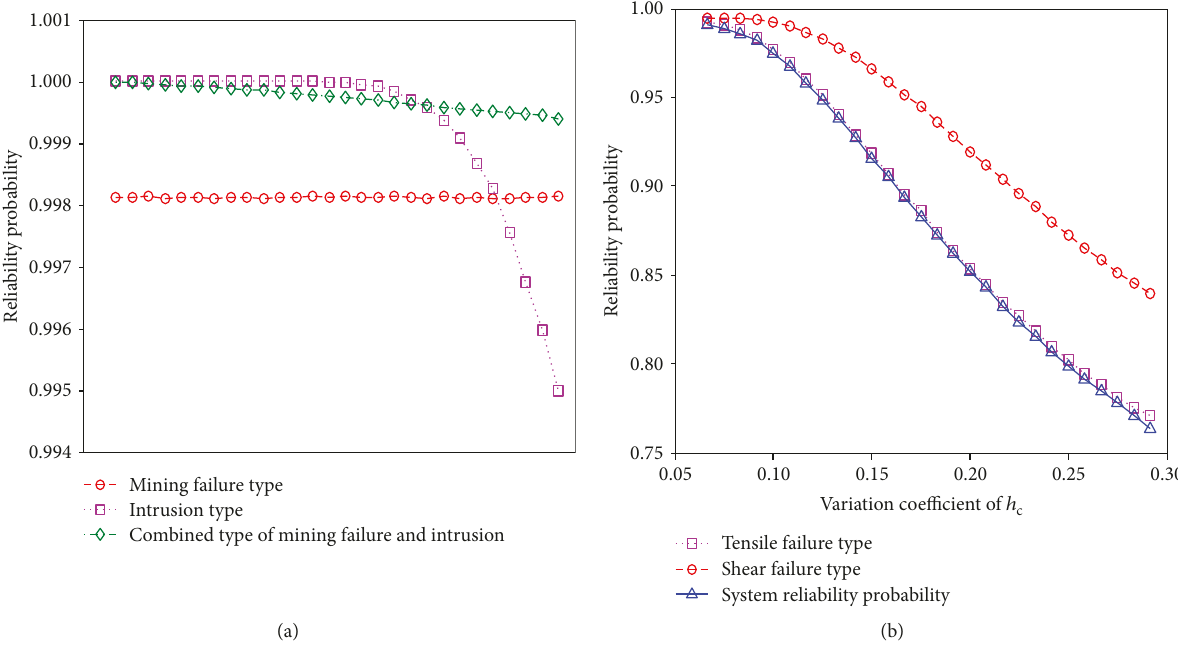
Figure 8: Relationship between variation coe ffi cient of random variables h c and reliability probability. (a) Failure modes of mining failure, intrusion, and the combination mining failure and intrusion and (b) modes of shear, tensile failure in key strata, and system